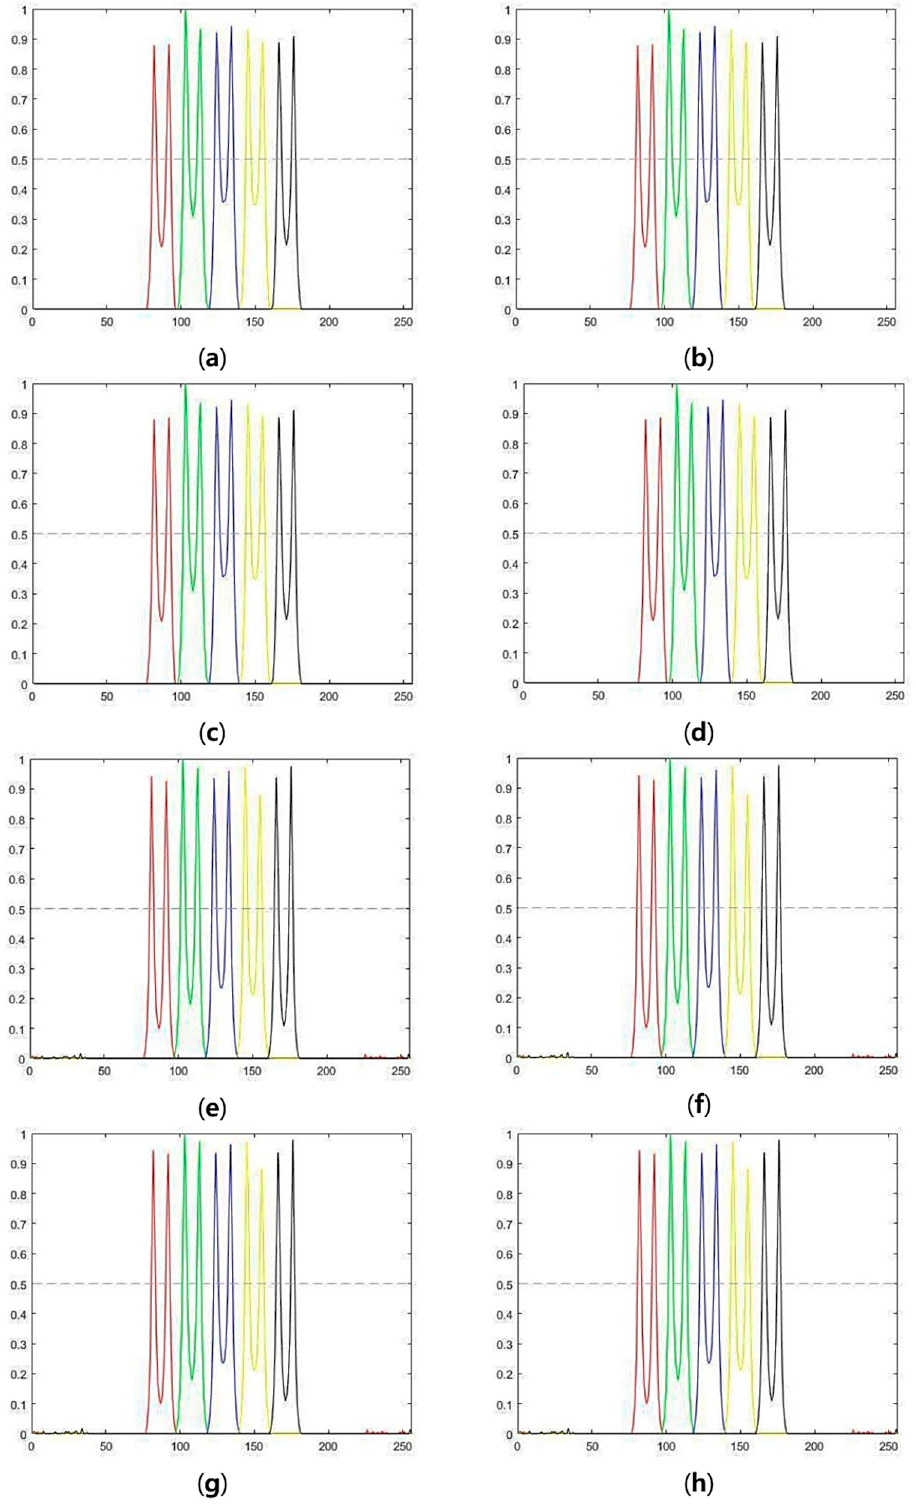
Figure 8. Intensity profiles of deconvolution results for 15 dB images: ( a ) Depth-invariant symmetric OSL algorithm, ( b ) depth-invariant symmetric GEM algorithm, ( c ) depth-variant symmetric OSL algorithm, ( d ) depth-variant symmetric GEM algorithm, ( e ) depth-variant symmetric OSL algorithm, ( f ) depth-variant asymmetric GEM algorithm, ( g ) depth-variant asymmetric OSL algorithm, and ( h ) depth-variant asymmetric GEM algorithm.